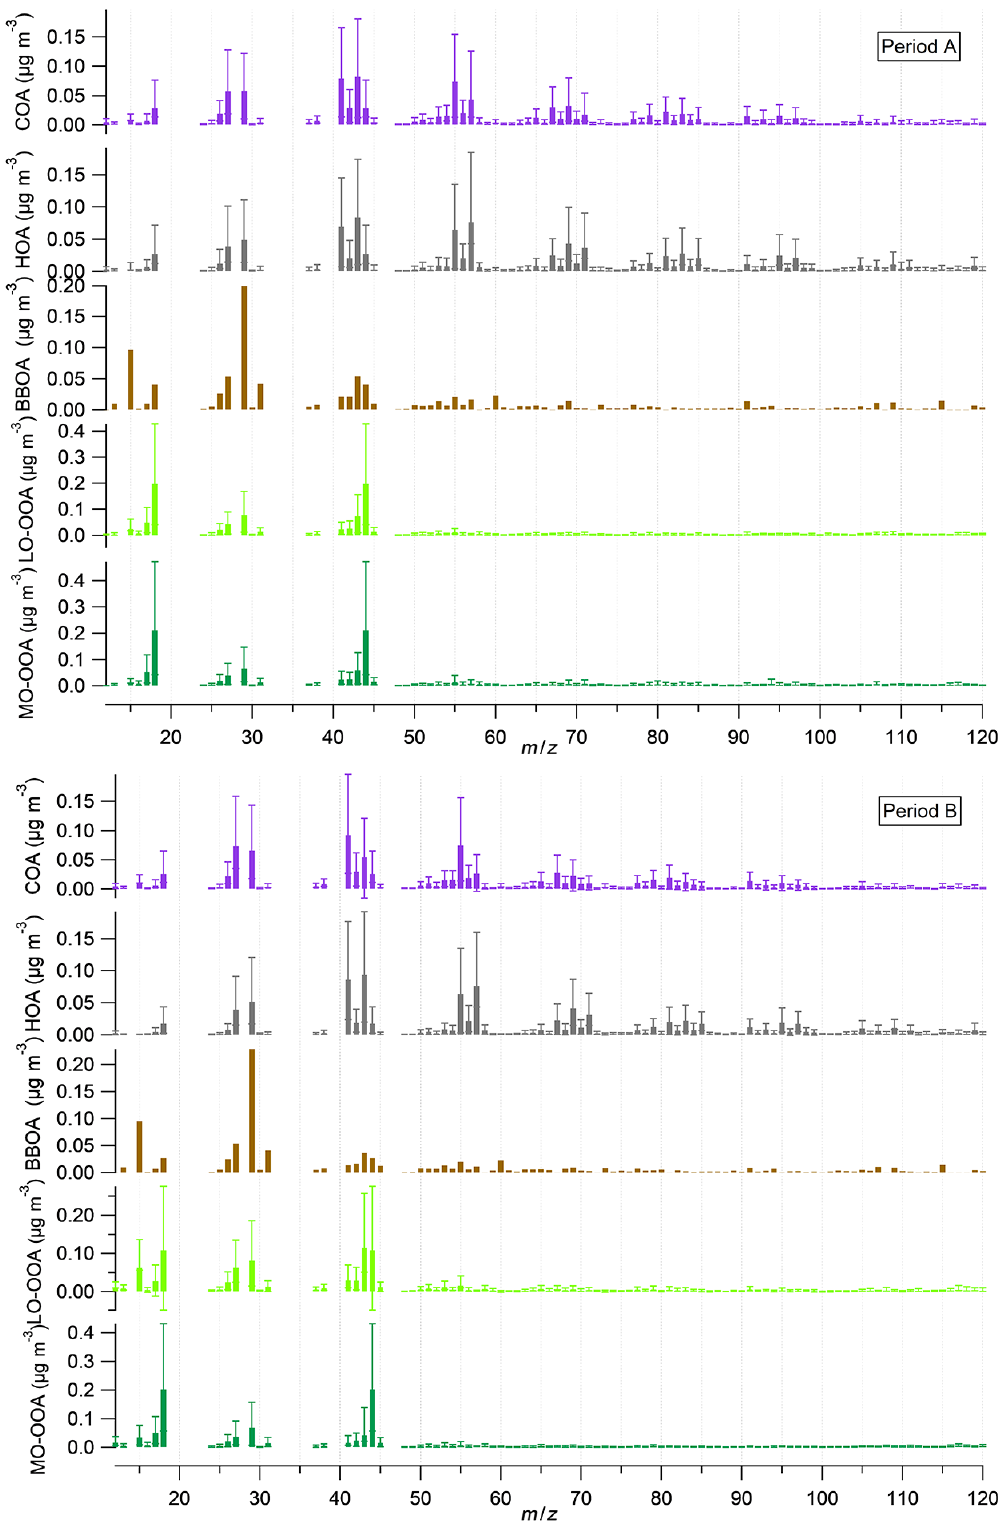
Figure 3. Mass spectra of the five OA factors for periods A and B. Stick lines are averaged values over all seasons for a given period. Error bars represent maximum and minimum values of all seasons. Thus, BBOA is lacking error bars as it is only present in one season.